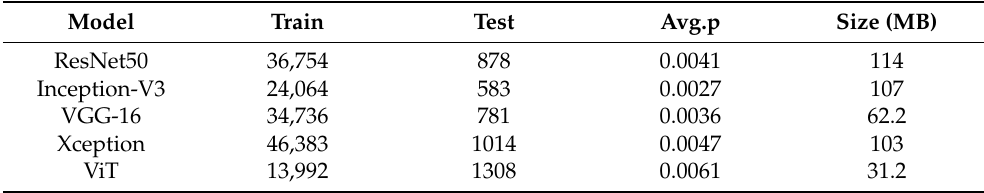
Table 8. A comparison of the classification results of five-fold cross-validation experiment on train and test sets of 8 × 8 pixels patches. Train (Average training time), Test (Average test times) and Avg.p (Single picture prediction time) (In